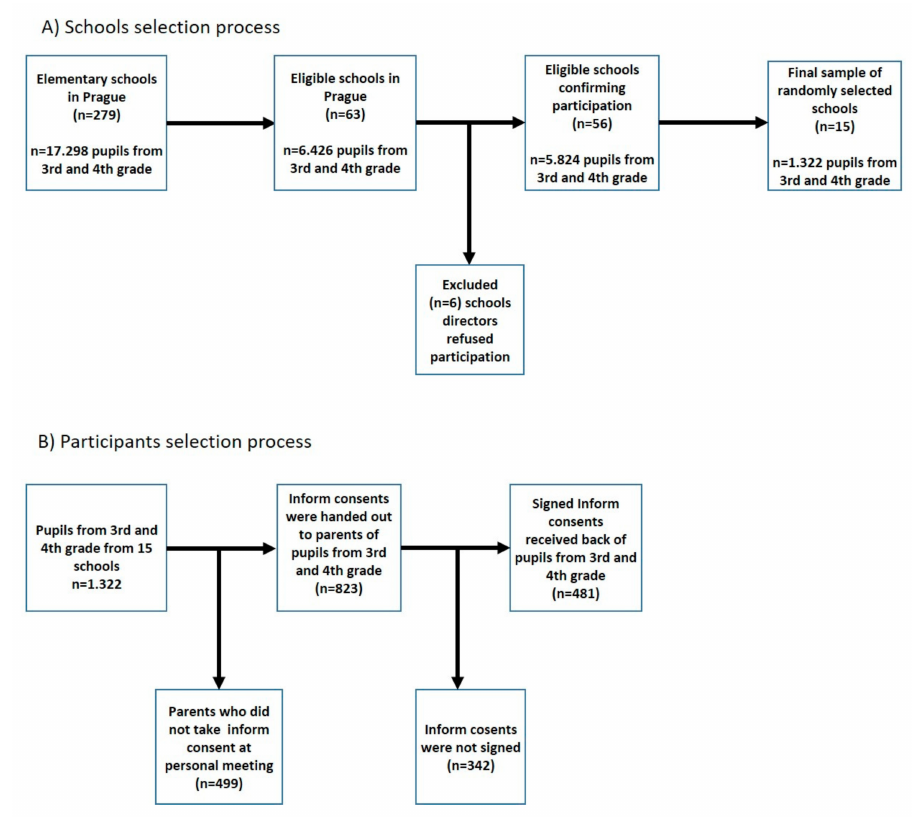
Figure 1. Schools and participant selection flow